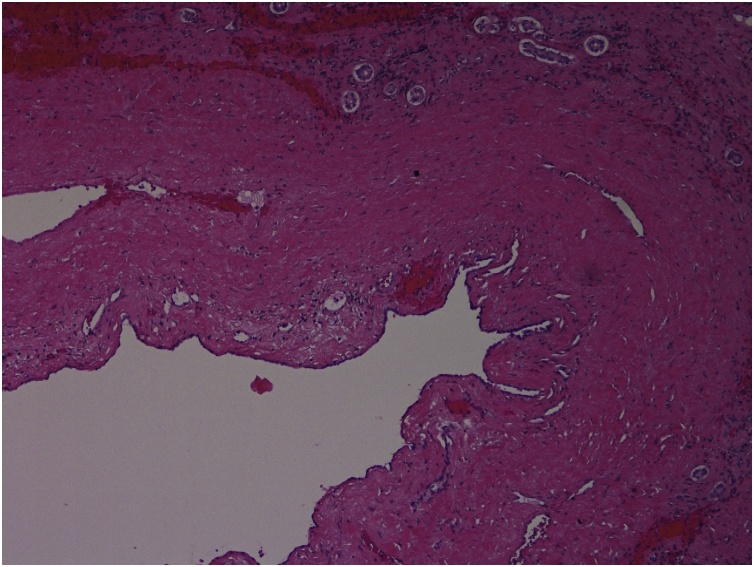
Histological examination of the cyst, showing flat epithelium with fibrous connective tissue (H & E staining, x100 original magnification).